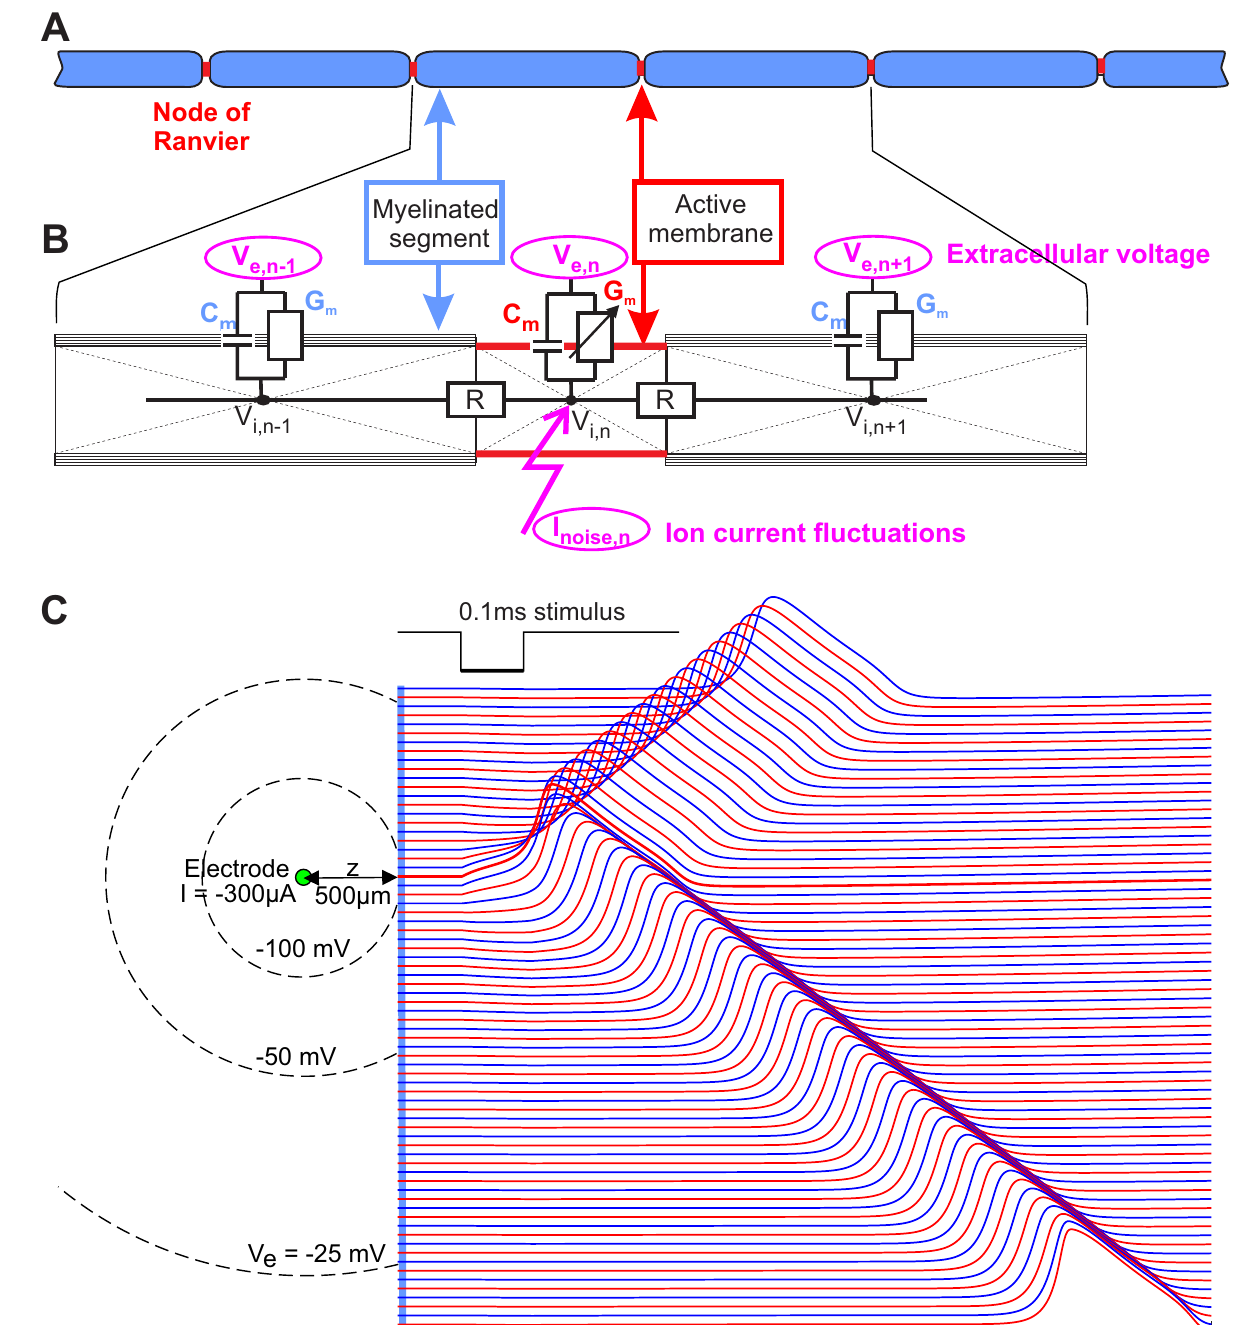
Fig 2. Compartment model of a myelinated axon. A: Geometry. The active compartments (nodes of Ranvier) are marked in red, the passive ones (internodes) in blue. B: Corresponding electrical network model. Independent noise currents I noise,n are added to the active compartments. The stimulating current from the electrode defines the extracellular potential (V e ) which causes a change of intracellular potential (V i ) depending on capacitance C m and conductance G m of the membrane and the intracellular resistance R. All influences from outside are marked via ellipses in magenta. C: Top view of the electrode and axon with equipotentials (left) and voltage profiles of active (red) and passive (blue) compartments (right). The excitation is initiated at the NoR closest to the electrode (thick red line). The uppermost 30 (of 101) compartments are not shown; simulation without